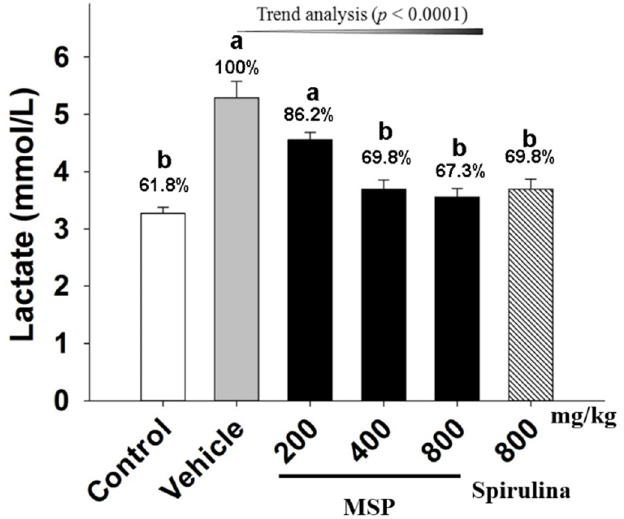
Figure 3. Effect of Millettiae speciosae Champ. total polysaccharides (MSP) on the levels of plasma Lac in mice after swimming for 30 min. Control group (open column), vehicle group (grey column), MSP ‐ treated groups (200,400,800 mg/kg/day, black column), spirulina group (800 mg/kg/day, twill column). Data are mean ± standard error of the mean (SEM) with n = 8 mice per group. Bars with different letters (a, b) are significantly different at p < 0.05. Percents shown above the bars indicate the percentage to the vehicle treatment.